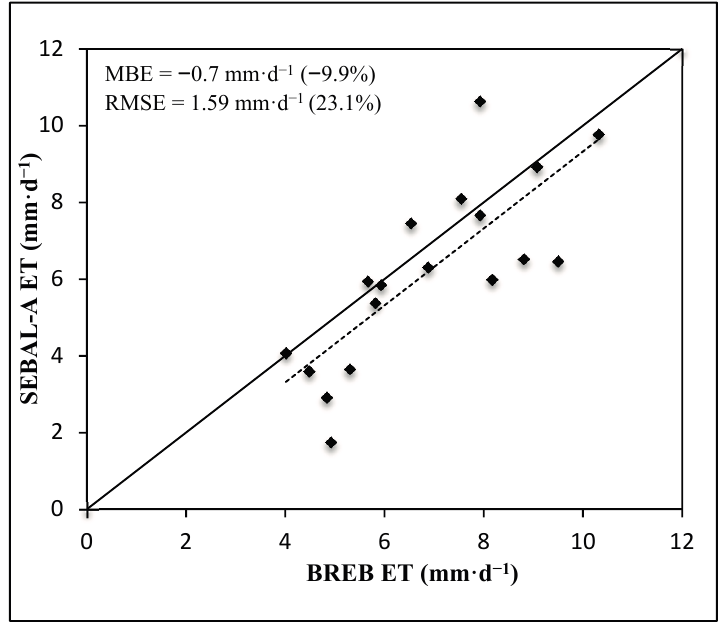
Figure 1. SEBAL-A crop ET compared to measured-ET for corn (from limited and fully irrigated